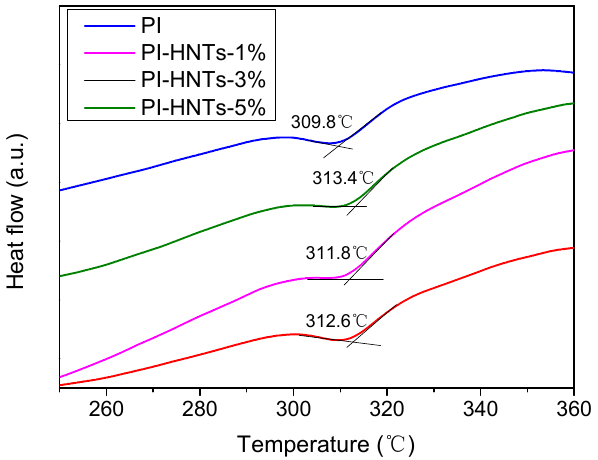
Figure 7. DSC of PI, PI-HNTs-1%, PI-HNTs-3%, and PI-HNTs-5%.